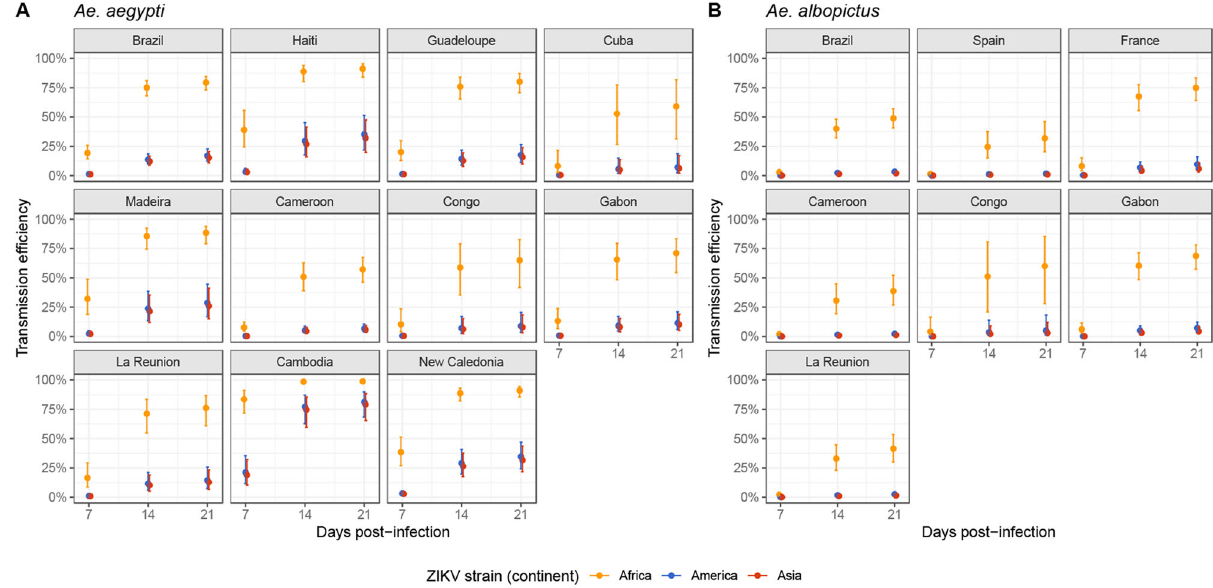
Fig.2|Model-predictedtransmissionef fi ciencyof Aedes mosquitoesaccording totimesinceinfection,splitbycountryofmosquitosampling. TEpredictedfor ( A ) Ae. aegypti and ( B ) Ae. albopictus . Countries are ordered to re fl ect geo-